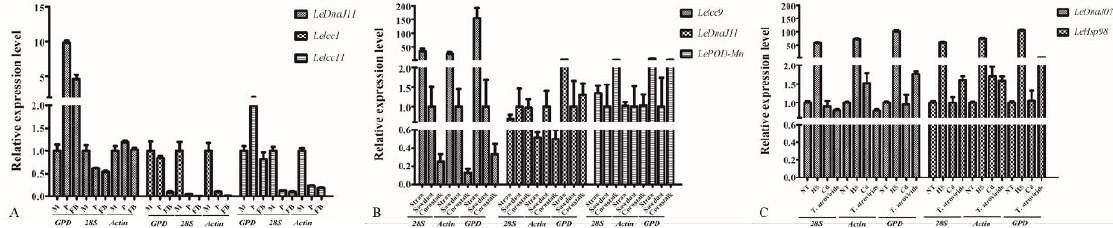
Figure 3. The relative expression levels of seven genes normalizing by the selected reference genes under different experimental conditions. ( A ) qRT-PCR analysis of three genes normalizing by the selected reference genes during different development stages; ( B ) qRT-PCR analysis of three genes normalizing by the selected reference genes in different substrates; ( C ) qRT-PCR analysis of three genes normalizing by the selected reference genes under different stress conditions.